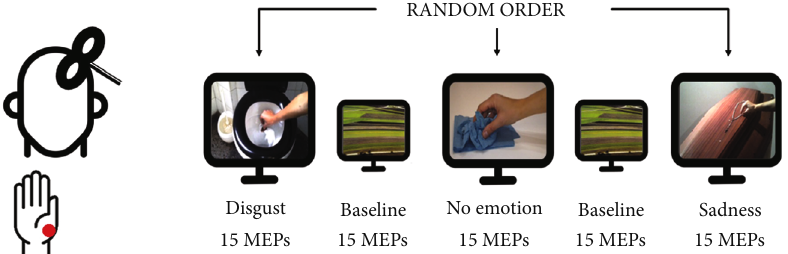
Figure 1: Experimental paradigm. Corticospinal excitability of the left primary motor cortex was evaluated while subjects were watching a reach-to-grasp movement embedded in two emotional contexts (disgust and sadness) and in a no-emotion context. Motor-evoked potential (MEPs) were recorded from abductor pollicis brevis (APB) muscle. A video showing a landscape was used as wash out